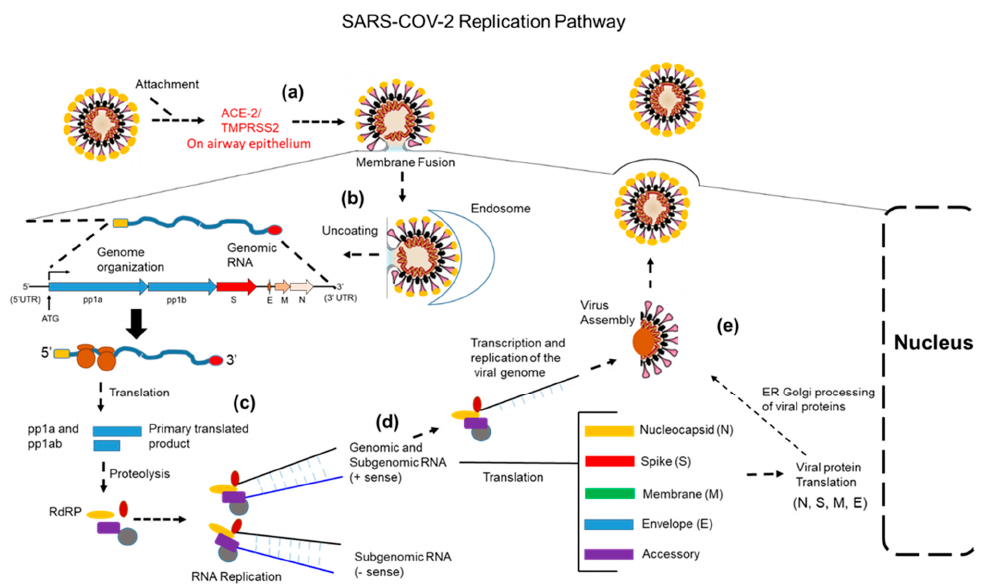
Figure 1. SARS-CoV-2 replication in human airway epithelium: ( a ) initiation of infection is ac- complished via binding of the viral spike glycoprotein to ACE-2/TMPRSS2 (serine protease); ( b ) membrane fusion, endosomal uptake and release of the viral genomic RNA; ( c ) translation of the pp1a/pp1b loci results in a polyprotein that is proteolytically cleaved to produce several proteins that assemble into the RdRP/replication complex; ( d ) RNA replication proceeds